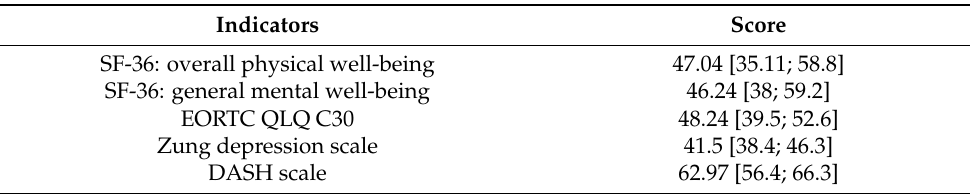
Table 3. The results of the psychological and functional scales in group of patients after breast cancer treatment.